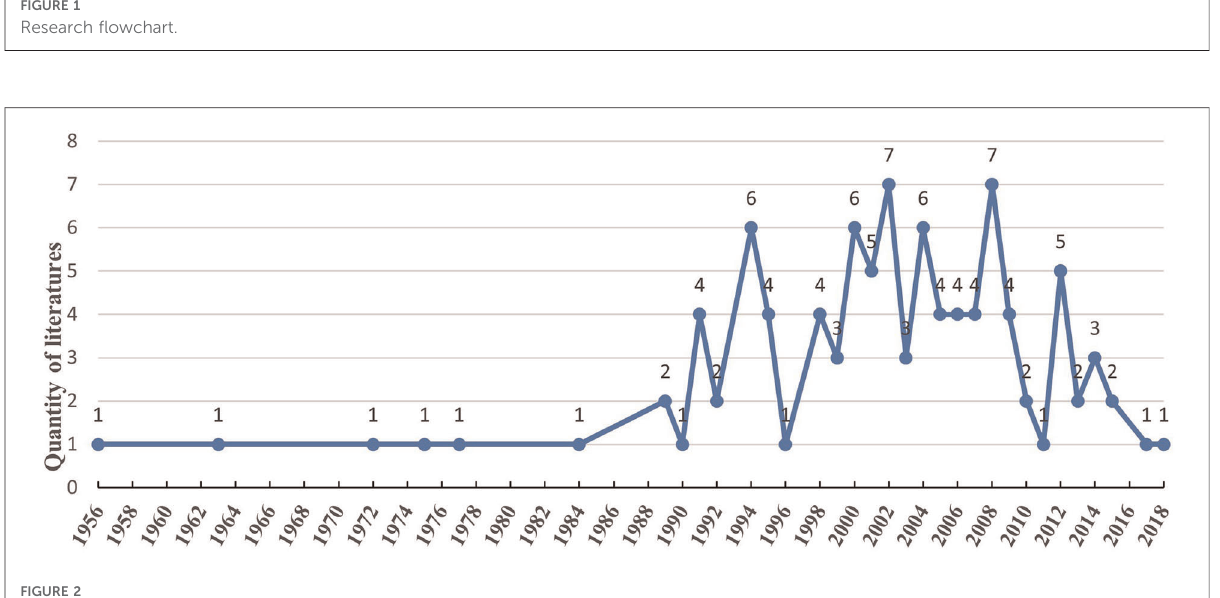
FIGURE 2 Annual publication of the top 100 most-cited